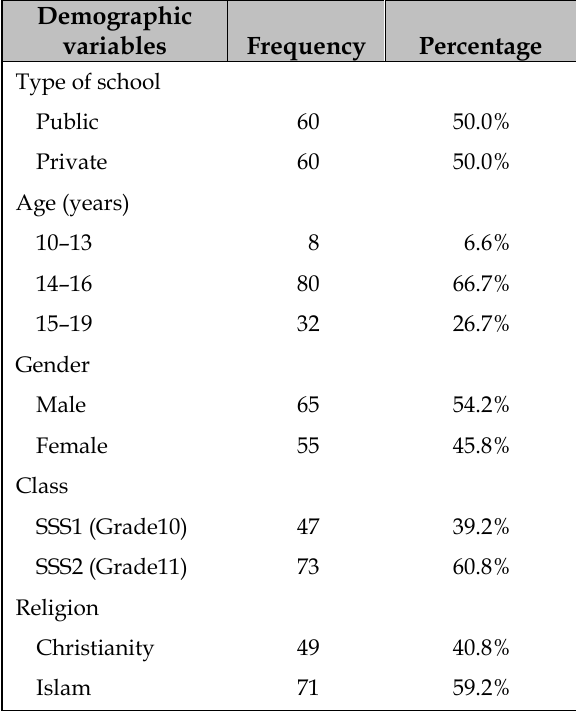
Table 1 Demographic profile of peer educator (PEs)